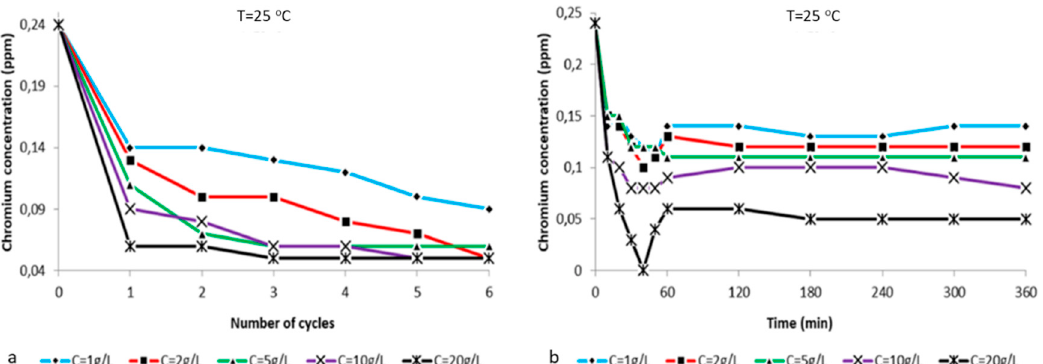
Figure 10. ( a ) Chromium ion concentration vs number of treatment cycles with zeolite X at T = 25 °C and pH = 5.5 for the ratios (i) 2:1 g/L, (ii) 2:2 g/L, (iii) 2:5 g/L, (iv) 2:10 g/L and (v) 2:20 g/L potassium dichromate:zeolite X. ( b ) Chromium ion concentration vs time (10 min for the first treatment hour and then every 1 h) at T = 25 °C and pH = 5.5 for the ratios (a) 2:1 g/L, (b) 2:2 g/L and (c) 2:5 g/L, (d) 2:10 g/L and (e) 2:20 g/L potassium dichromate:zeolite X .